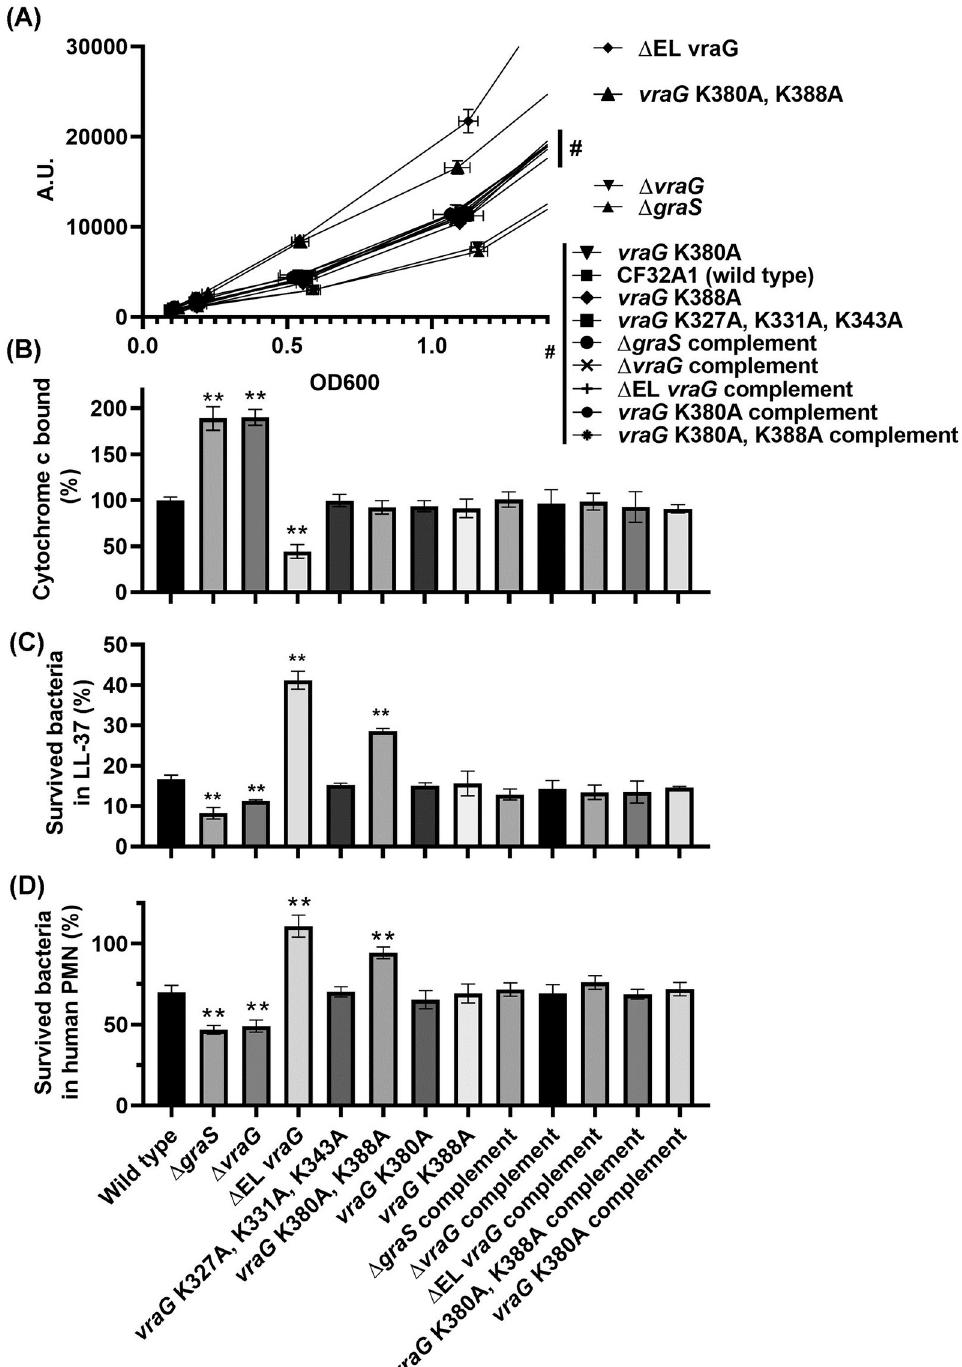
Fig 1. Effects of EL vraG mutants on GraRS two-component system. (A) GFPuvr expression driven by the mprF promoter among various mutants. The fluorescence of GFPuvr (arbitrary unit, A.U. in y-axis) and OD600 in x-axis were monitored every hour for 5 hours. The strains for overlapped lines drawn by nine samples (|#) are separately listed below. (B) cytochrome c binding assay. Cells grown to the mid-log phase were treated with 0.25 mg/ml cytochrome c, and the percentages of cytochrome c bound were normalized vs. the wild type cells set at 100%. All the measurements were collected from at least three biological replicates. (C) LL-37 2hr killing assay and (D) PMN killing assay were independently performed at least three times. The representative data set were displayed with technical replicates. The asterisks ( �� ) indicate p < 0.01.